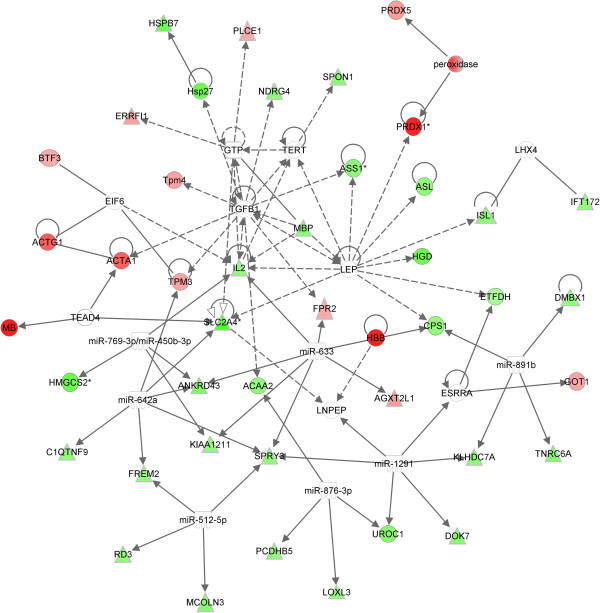
The effects of adequate selenium and folate post-weaning on differentially expressed genes and proteins in the liver of female mice exposed to high-fat diets with low selenium and folate during gestation and lactation. A network of genes (Δ) and proteins (Ο) was generated using Ingenuity Pathways Analysis software. All genes and proteins differentially expressed in the liver in response to altered selenium and folate levels were included, and the IPA knowledge base developed links between these based on direct interactions previously reported in the literature. Genes and gene products with higher expression in the deficient animals are shown in red, those with lower expression in green. This approach was used to identify whether any genes or proteins showed direct interactions with a large number of other genes or proteins, and may therefore be of particular importance in mediating the effects of altered dietary selenium and folate.